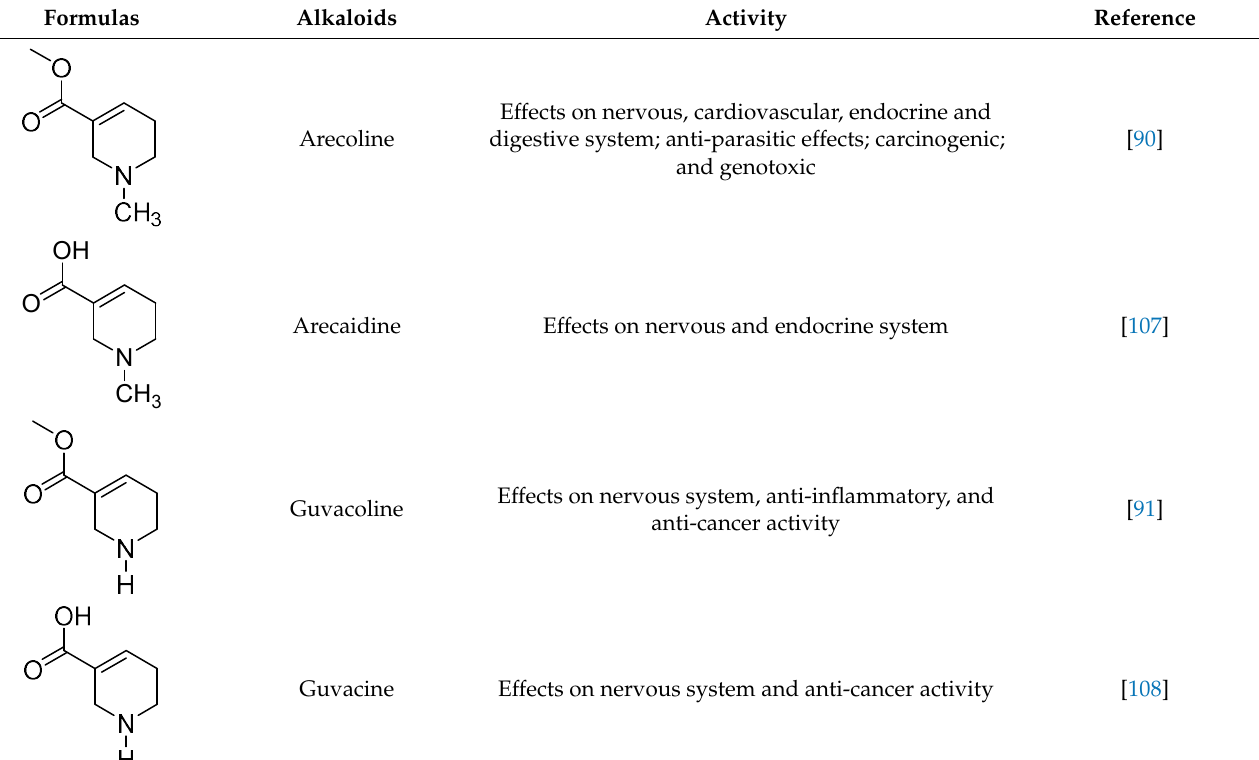
Table 3. Major alkaloids found in AN and their activities.